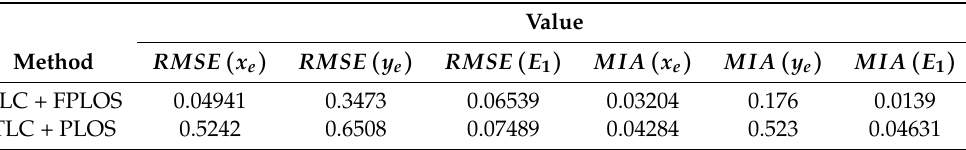
Table 1. Performance comparisons of different methods. MIA, mean integral absolute. FPLOS, fuzzy predictor